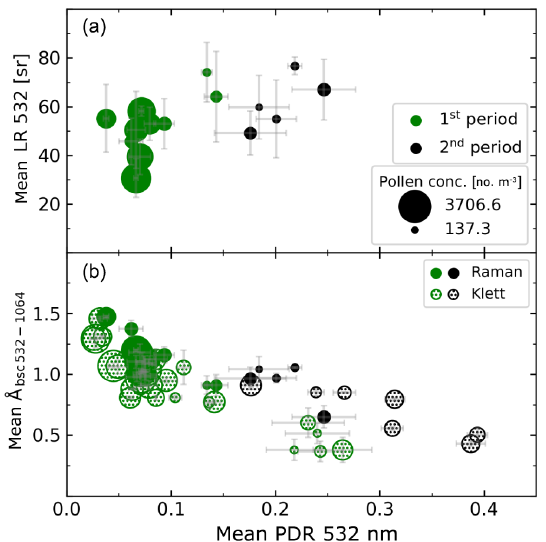
Figure 5. Mean values of optical properties of the detected pollen layers during the period 5 to 15 May. Error bars denote the stan- dard deviation, and marker size denotes the pollen concentration. Marker color denotes the measurement period. Green dots are mea- sured from 5 to 10 May and black dots from 12 to 15 May. Solid dots indicate Raman retrievals and dotted markers the Klett solu- tion. Panel (a) shows lidar ratio at 532nm vs. particle depolarization ratio at 532nm. Panel (b) shows backscatter-related Ångström ex- ponent at 532–1064nm vs. particle depolarization ratio at 532nm.